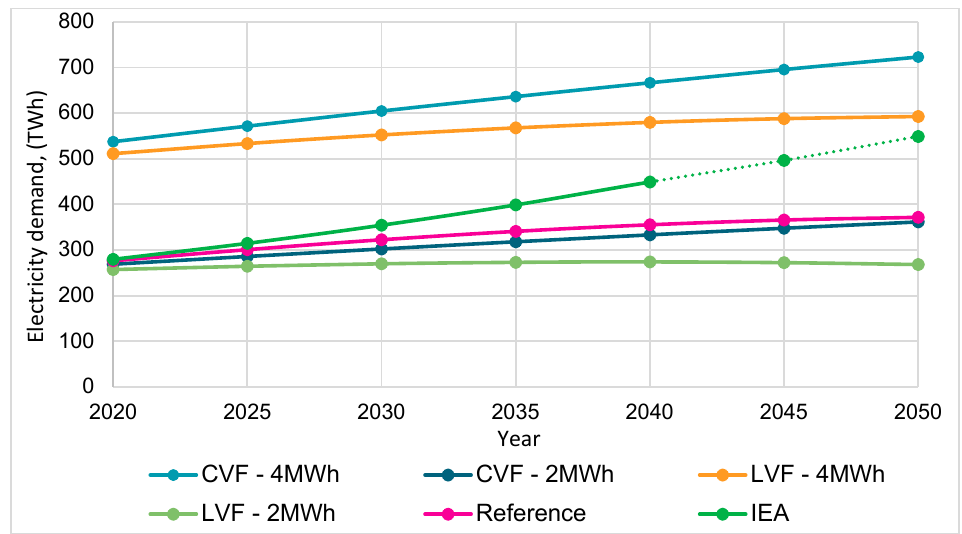
Figure 2. Projections of electricity demand to the year 2050. Source: own elaboration with data from [2,30].